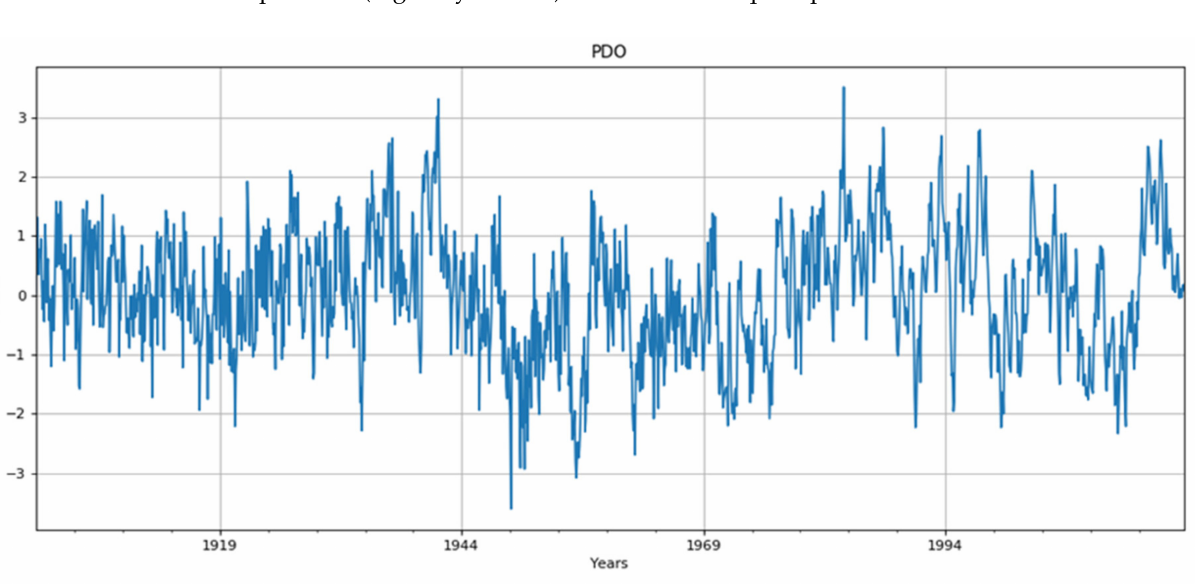
Figure 17. Time series of the PDO index.